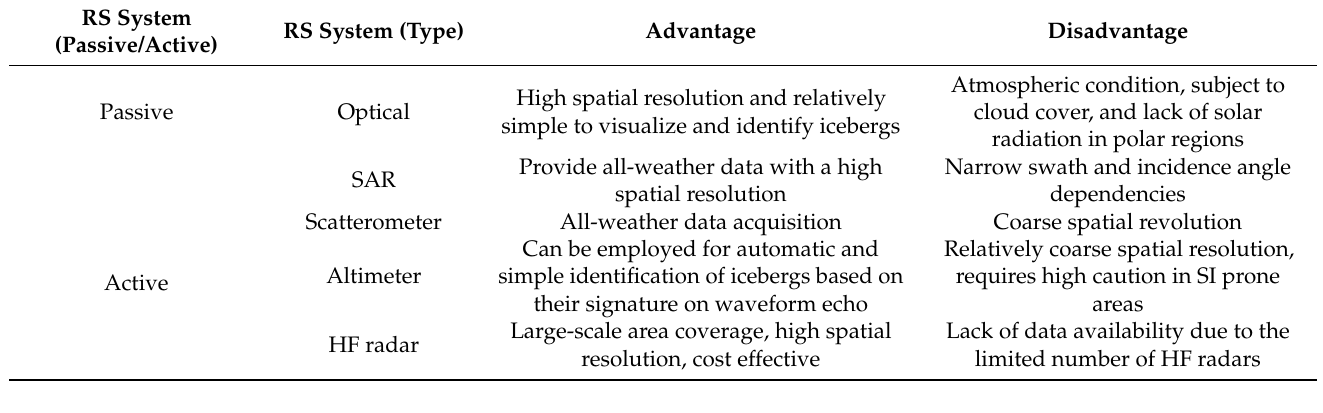
Table 1. Different RS systems for iceberg studies along with their advantages and disadvantages.